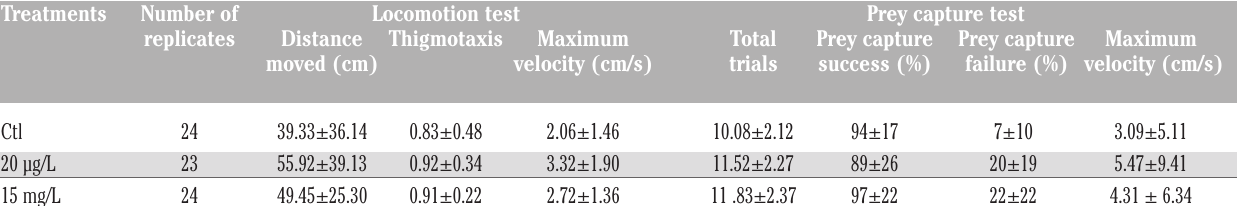
Table 1. Summary table including the number of biological replicates per treatment and results of locomotion and prey capture tests. Mean ± SD.